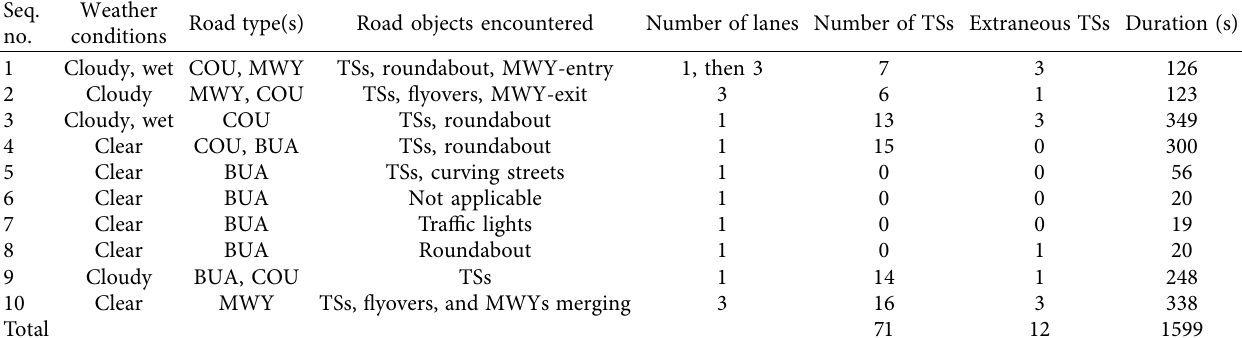
Table 21: Brief description of the component sequences that make up a particular compiled chain. All its component sequences had been recorded in at daytime on UK roads. The following abbreviations are used: COU � country road, BUA � built-up area, and MWY �